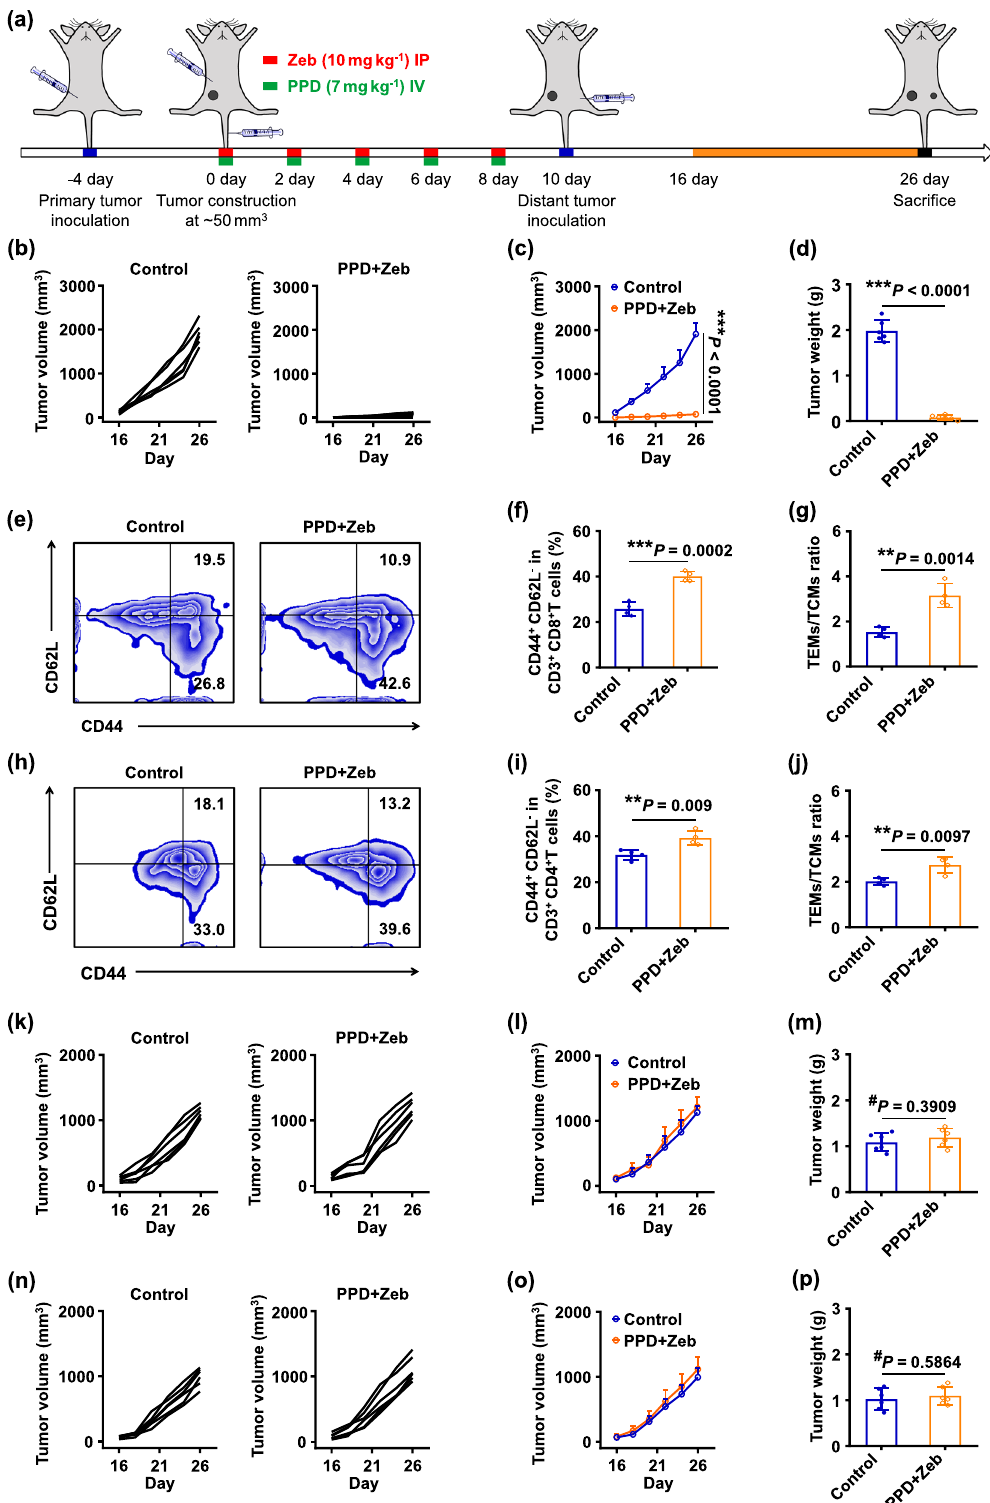
(Supplementary Figs. 108 and 109). The reason should be that PPD plus Zeb combination therapy greatly evoked a systemic immune memory effect (Fig. 7d – i) and effectively induced effector memory T cells to kill tumour cells, which fi nally prevented the lung and liver metastasis of tumour cells. On the basis of the above results, PPD plus Zeb combination therapy not only signi fi cantly inhibited tumour growth by